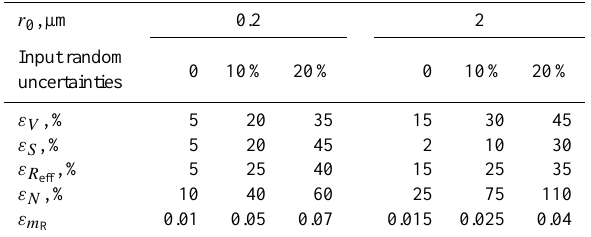
Table 1. Uncertainties of particle parameters estimation. Results are obtained for PSDs d V with modal radii 0.2µm and 2 µm for input dln r errors ε =0, 10%,